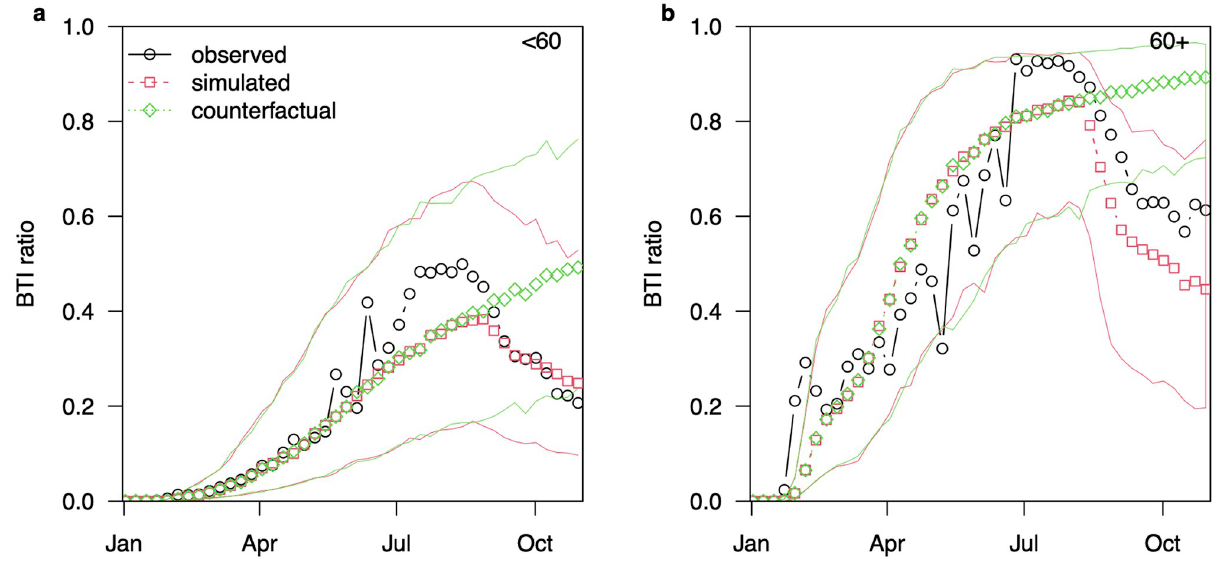
Fig 5. The observed and simulated BTI ratio in 2021. The observed (black circles) versus the simulated BTI ratios under the baseline, α = 1 (red squares) and counterfactual, α = 0 (green diamonds) scenarios for < 60 age group in panel (a) and for 60+ age group in panel (b). These results correspond to Fig 4, showing the BTI ratio instead of case numbers. Red and blue curves indicate the 95% CI ranges for each scenario.